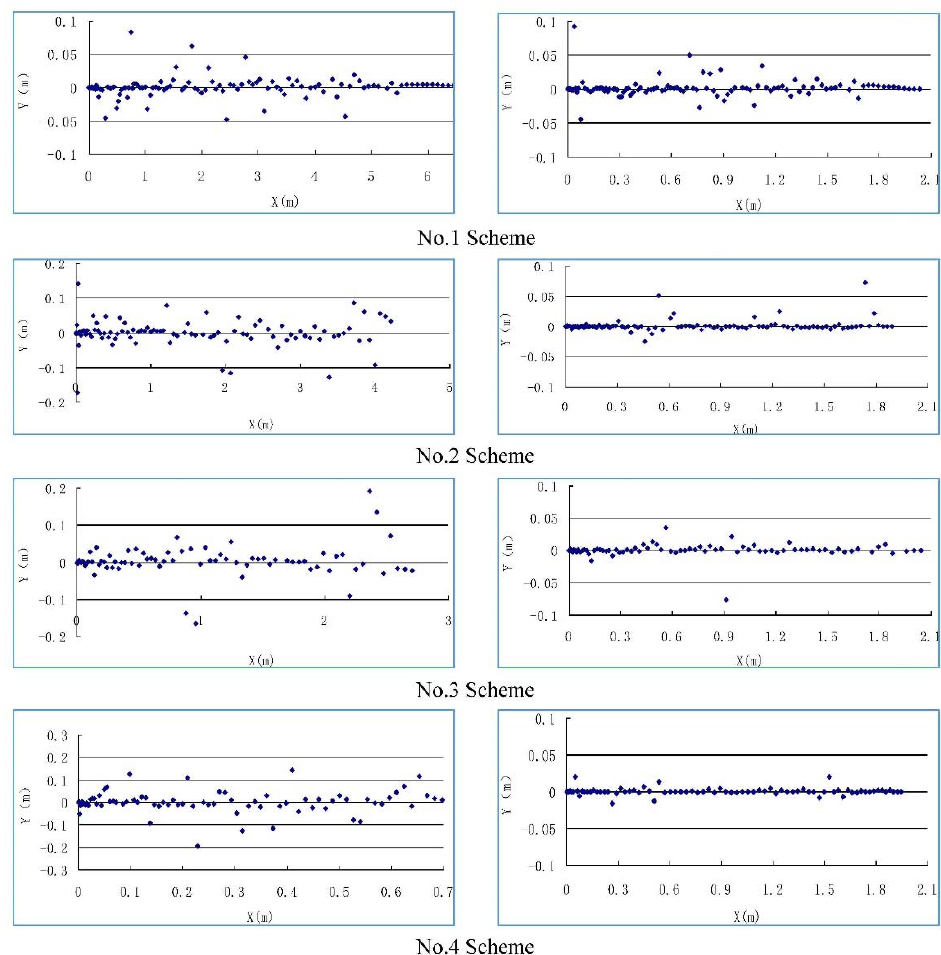
Figure 7. Comparison of the shearer coordinate distribution obtained by original data and error compensation.